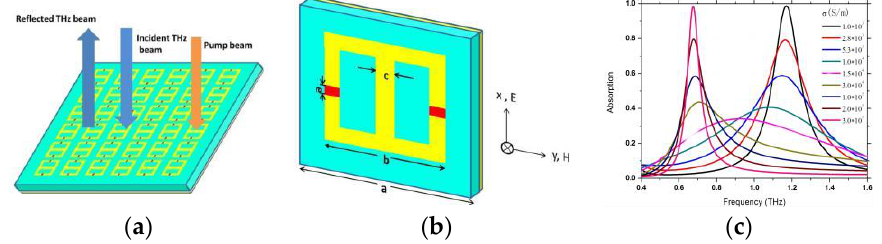
Figure 10. ( a ) The unit cell of the switchable metamaterial absorber structure. ( b ) The array of the switchable metamaterial absorber. In this metamaterial absorber, a, b, c, e represent symbols of geometric dimensions and the axes indicate the polarization and propagation direction of the incident THz wave. ( c ) Simulated absorption spectrum at different values of silicon conductivity.